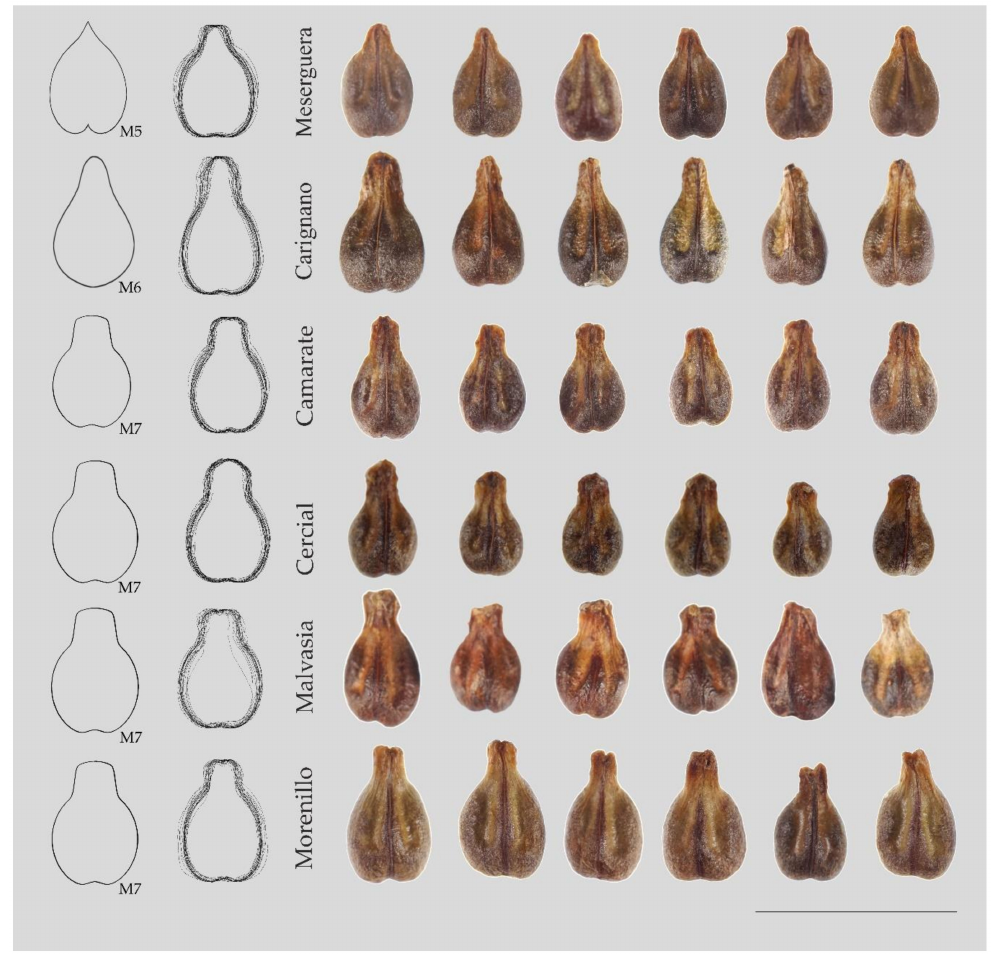
Figure 6. From left to right in all rows: Models used (M5, the elongated heart curve is applied in row 1; M6, the Fibonnacci’s pear is applied in row 2; and M7 is applied in rows 3 to 6); a figure composed of silhouettes of 20 seed images; representative images of seeds of the six V. vinifera ssp. vinifera cultivars analyzed. From top to bottom: Meserguera (row 1), Carignano (row 2), Camarate (row 3), Cercial (row 4), Malvasia (row 5) and Morenillo (row 6). The bar is equal to 1 cm.